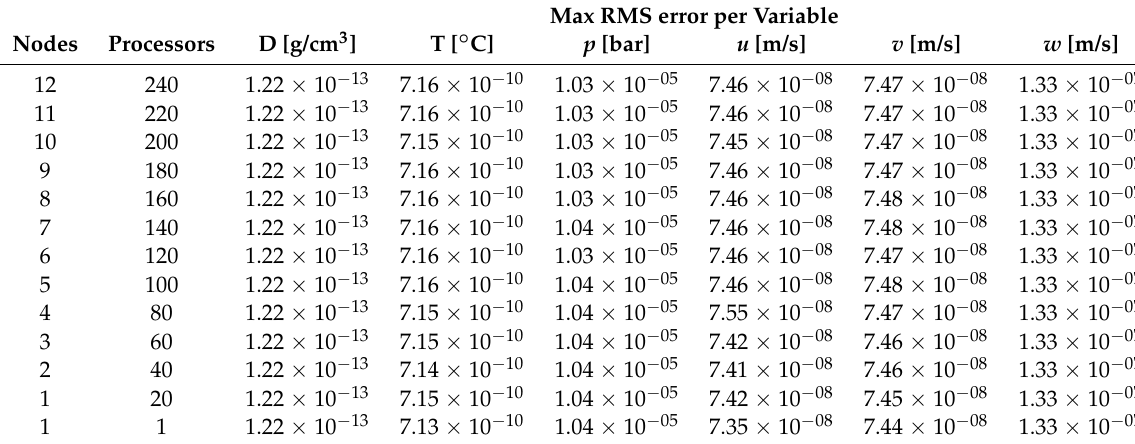
Table A1. Max Root-mean-squared (RMS) error per variable when comparing Serial GCCOM vs. Parallel GCCOM Model from 1 to 240 processors across 12 nodes.